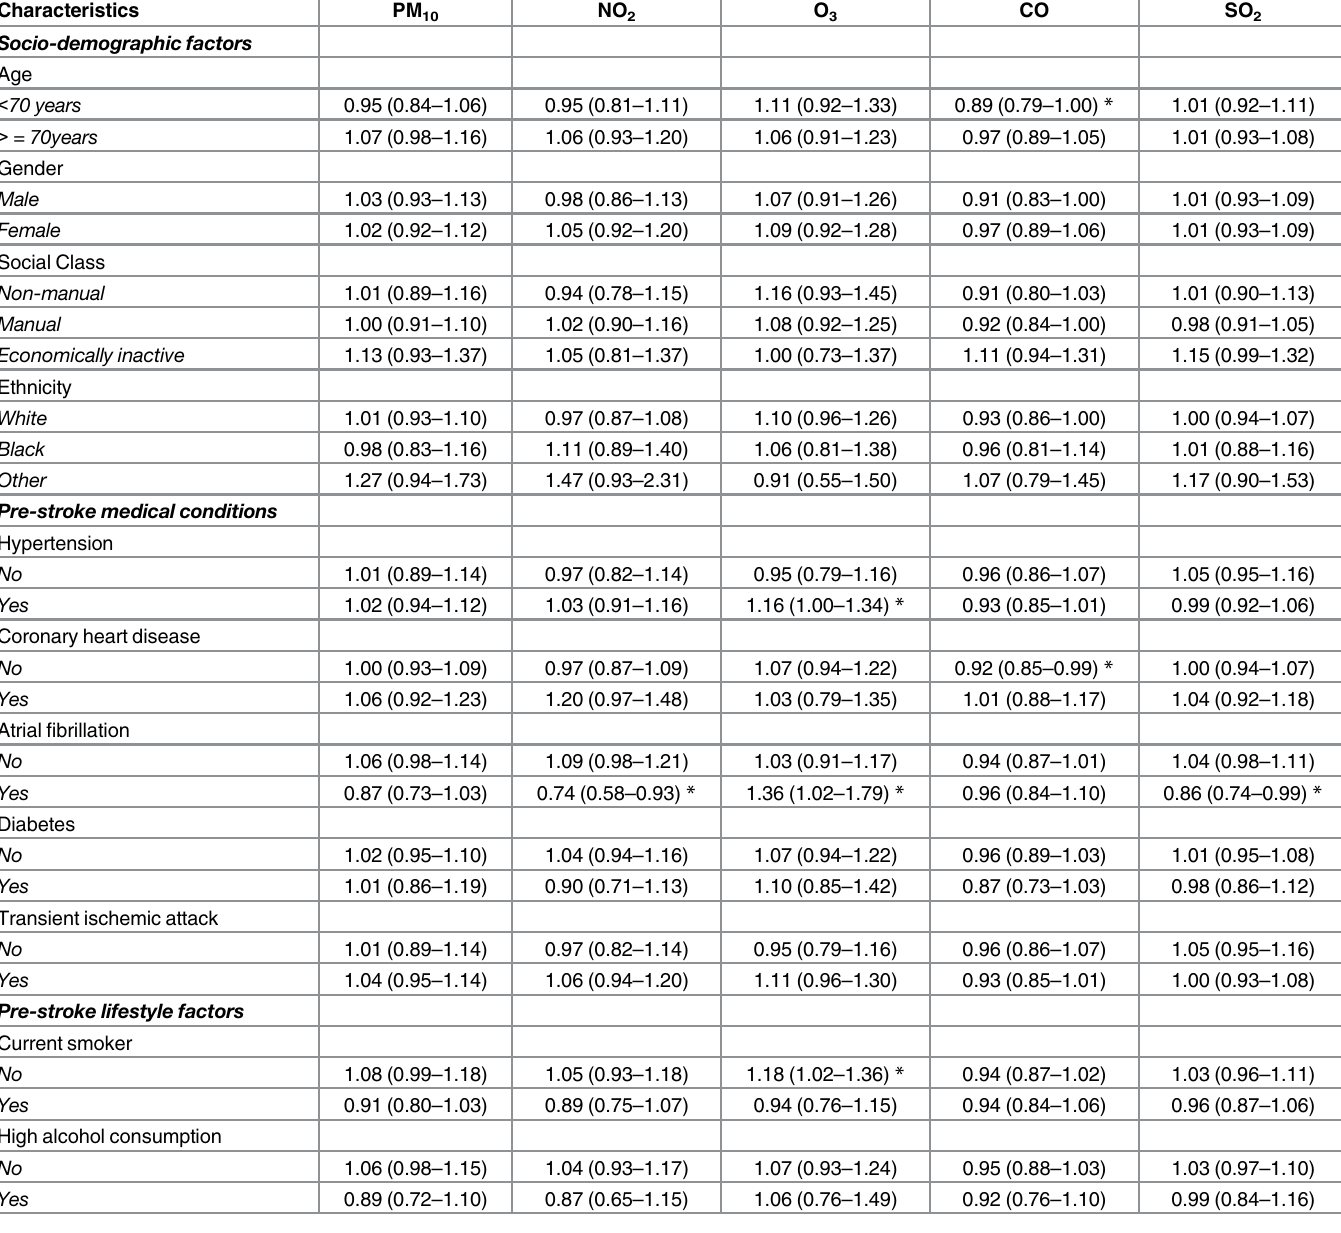
Table 5. Adjusted odds ratios (95% CI) for all ischemic stroke associated with an inter-quartile range increase in outdoor air pollutants (0 – 6 day average) by sociodemographic factors, lifestyle-related risk factors and pre-existing medical conditions, South London Stroke Register 1995 –